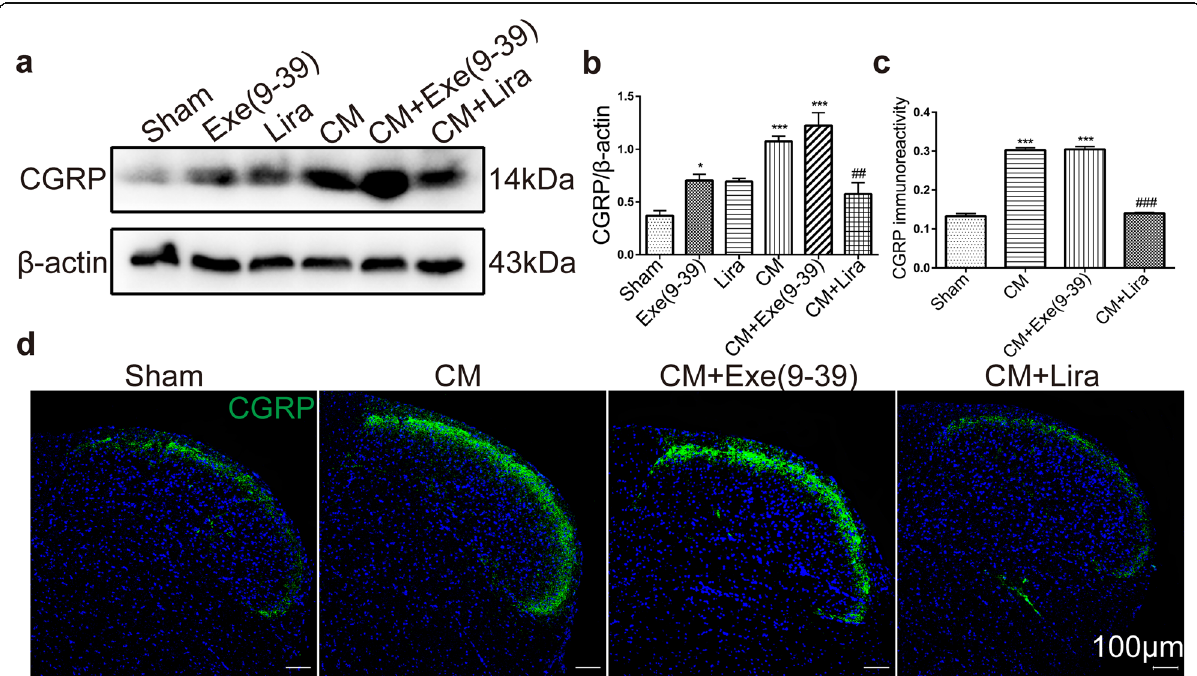
Fig. 4 Activation of GLP-1R reduced the upregulation of CGRP expression in the TNC in CM mice. a, b Western blots showing the alteration of CGRP protein levels in the TNC treated with liraglutide and exendin(9 – 39). The band intensities are presented as the percent (%) change relative to the sham group. Values are presented as mean ± SEM; n = 6/group; * p < 0.05 and *** p < 0.001 vs. sham group; ## p < 0.01 vs. CM group. c, d Representative immunofluorescence staining images of CGRP in the TNC ( c ) and the quantitative analysis of CGRP immunoreactivity ( d ). The results showed that liraglutide inhibited NTG-induced CGRP immunoreactivity, which was consistent with the western blot assessment. Data are presented as mean ± SEM; n = 4/group; six sections from each mouse; *** p < 0.001 vs. sham group; ### p < 0.001 vs. CM group. Scale bars: 100 μ